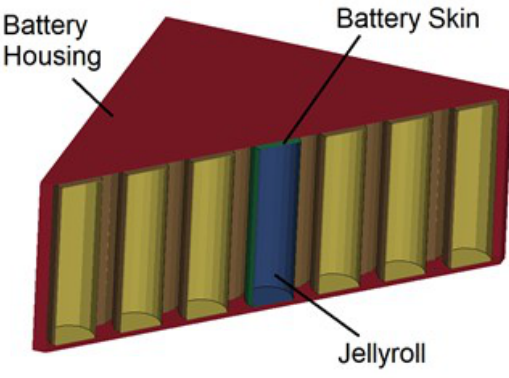
Figure 13. Internal Configuration of Battery Module.